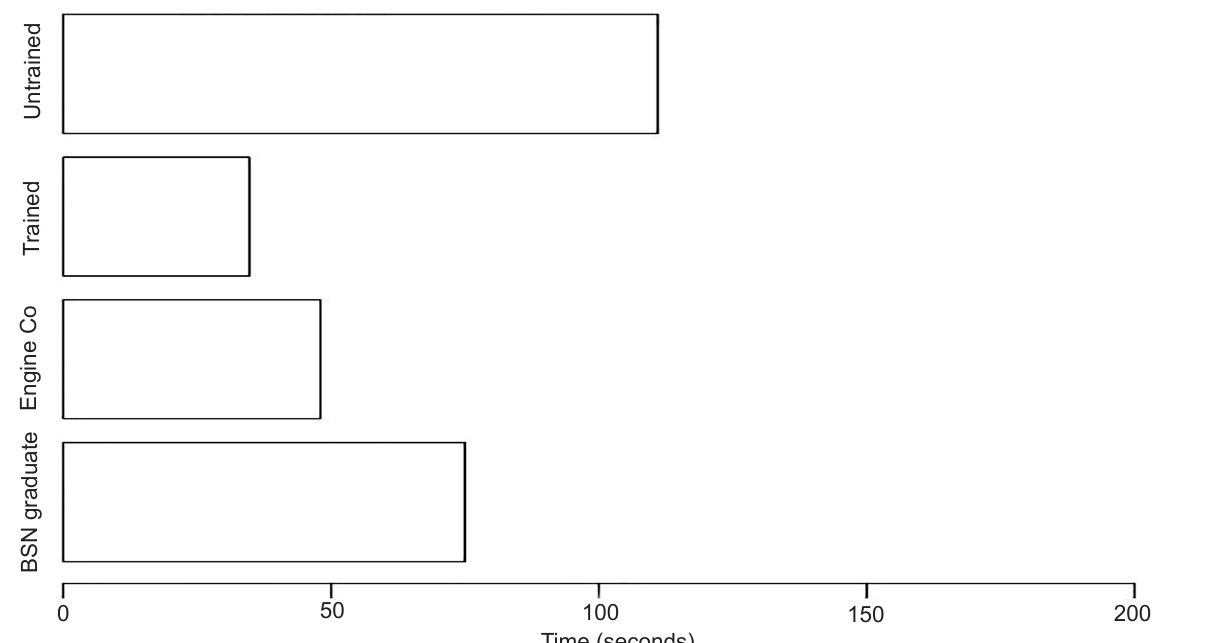
Figure 1. Time to first action of trained vs untrained groups in arterial hemorrhage control scenario, as well as of emergency medical services and healthcare (nursing graduates)